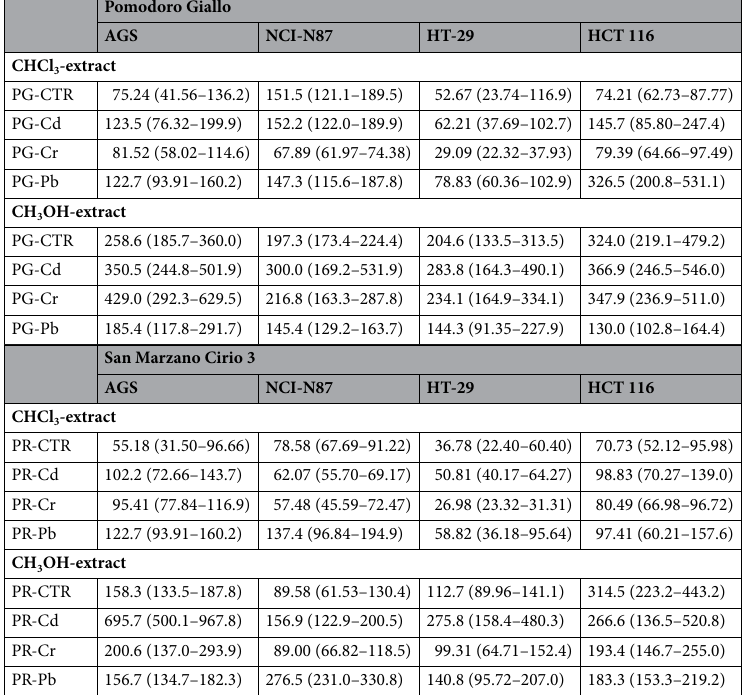
Table 4. Antiproliferative activity of chloroform and methanol extracts of Pomodoro Giallo and San Marzano Cirio 3. Antiproliferative activity expressed as IC50 (mg/L) values, with confidence limits (95% probability, in brackets), of chloroform and methanol extracts of Pomodoro Giallo fruits (PG) from plants grown in uncontaminated (PG-CTR) and contaminated (PG-Cd, PG-Cr, PG-Pb) soils and of San Marzano Cirio 3 (PR) from plants grown in uncontaminated (PR-CTR) and contaminated (PR-Cd, PR-Cr, PR-Pb) soils on AGS, NCI-N87, HT-29 and HCT 116 cells, after 72 h of